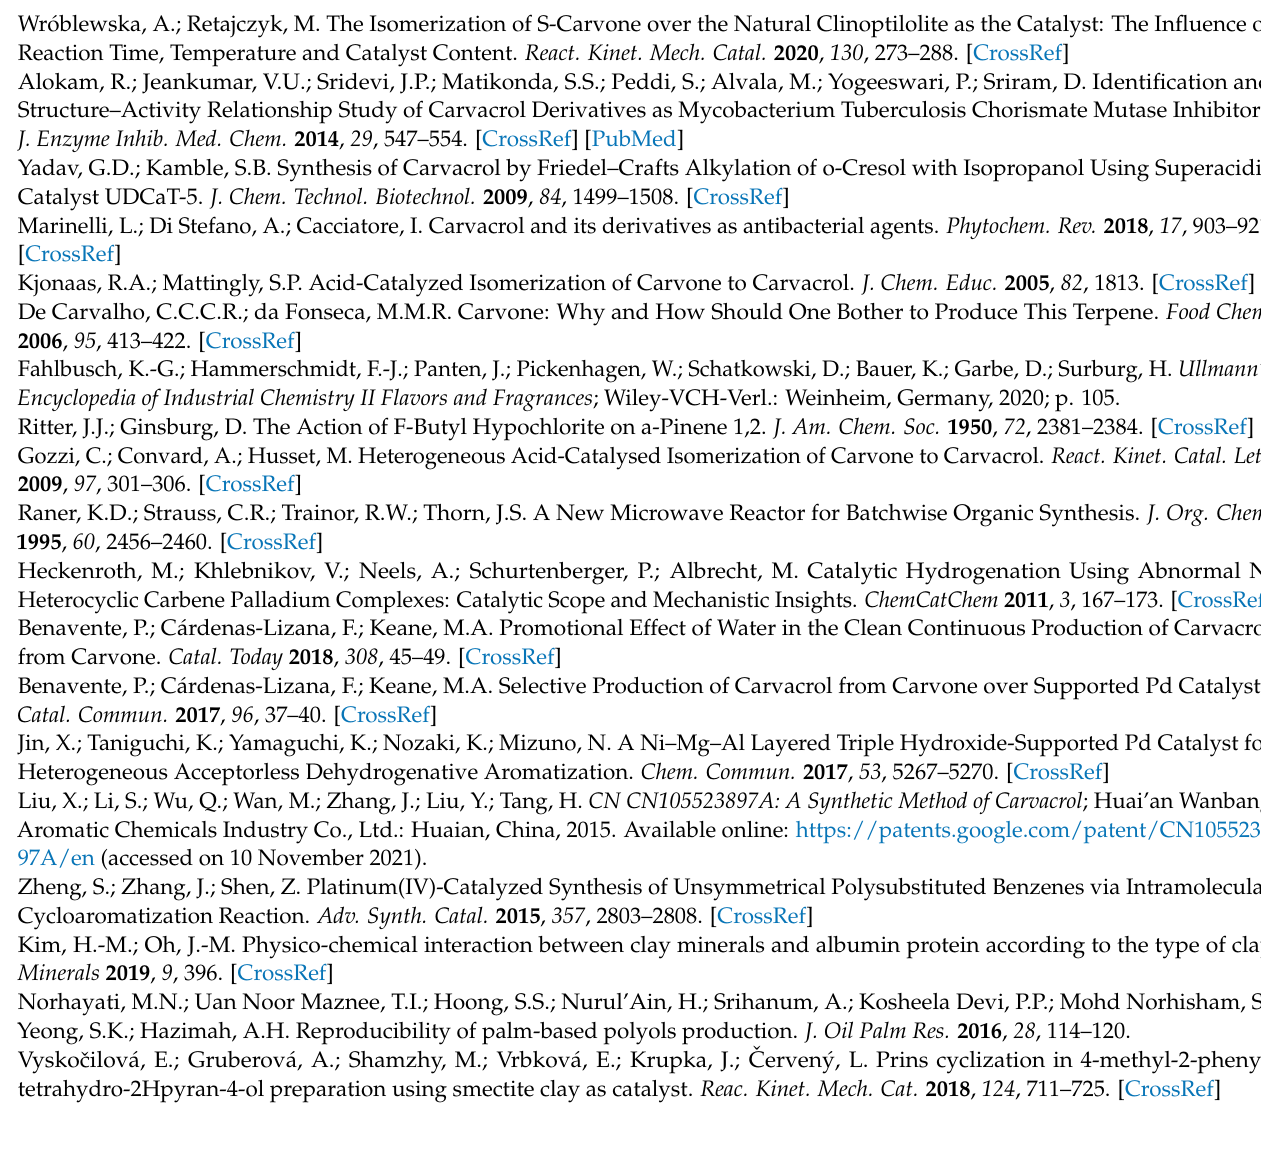
Figure S2: TPD-MS results for raw and acid-treated montmorillonite ( m / z = 79 signal), Figure S3: UV-Vis results for raw and acid-treated montmorillonite, Figure S4: Dependence of reaction rate on material acidity, Figure S5: Offered mechanism for carvacrol formation from 8-hydroxycarvone, Figure S6: Offered mechanism for 8-hydroxycarvone formation from carvone, Table S1:. XRF analy- sis